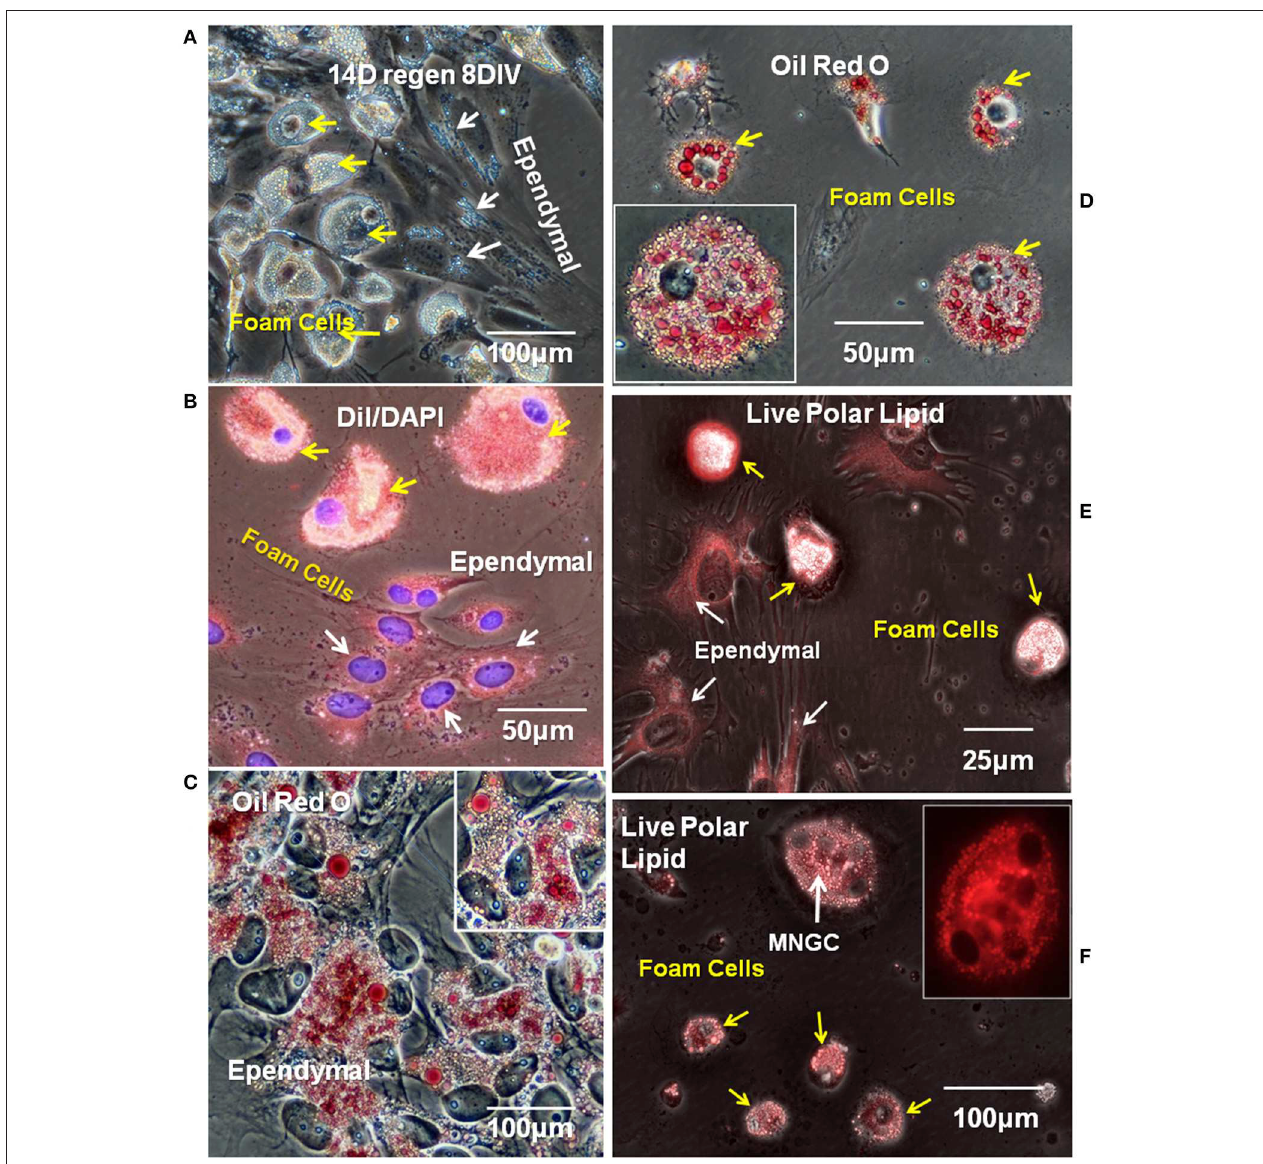
FIGURE 5 | Ependymal cells and foamy macrophages take up neutral and polarized lipids in regenerating spinal cord explants. (A) Lipid droplets were apparent ependymal (white arrows) and foamy macrophages (yellow arrow) in unstained explant cultures of 14 days regenerating spinal cord. Phase contrast image (B) Ependymal (white arrows) and foamy macrophages (yellow arrows) in regenerating explant cultures are labeled with polar lipid marker DiI. Fluorescence/Phase contrast image. (C) Ependymal cell lipid droplets label with neutral lipid marker Oil Red O. Phase contrast image. (D) Foamy macrophages lipid droplets also label with neutral lipid marker Oil Red O. Phase contrast image Insets in (C,D) show higher magnification images of ependymal cells and foamy cells, respectively. (E,F) Ependymal cells (white arrows in E ), foamy macrophages (yellow arrows in E,F ), and MNGCs (white arrow in F ) all labeled with a commercial polar lipid marker. Fluorescence/Phase image, Inset in (F) shows a higher magnification of an MNGC with 4 nuclei, fluorescence only. Regen, regenerating; DIV, days in vitro . Magnification bar is shown in the lower portion of each